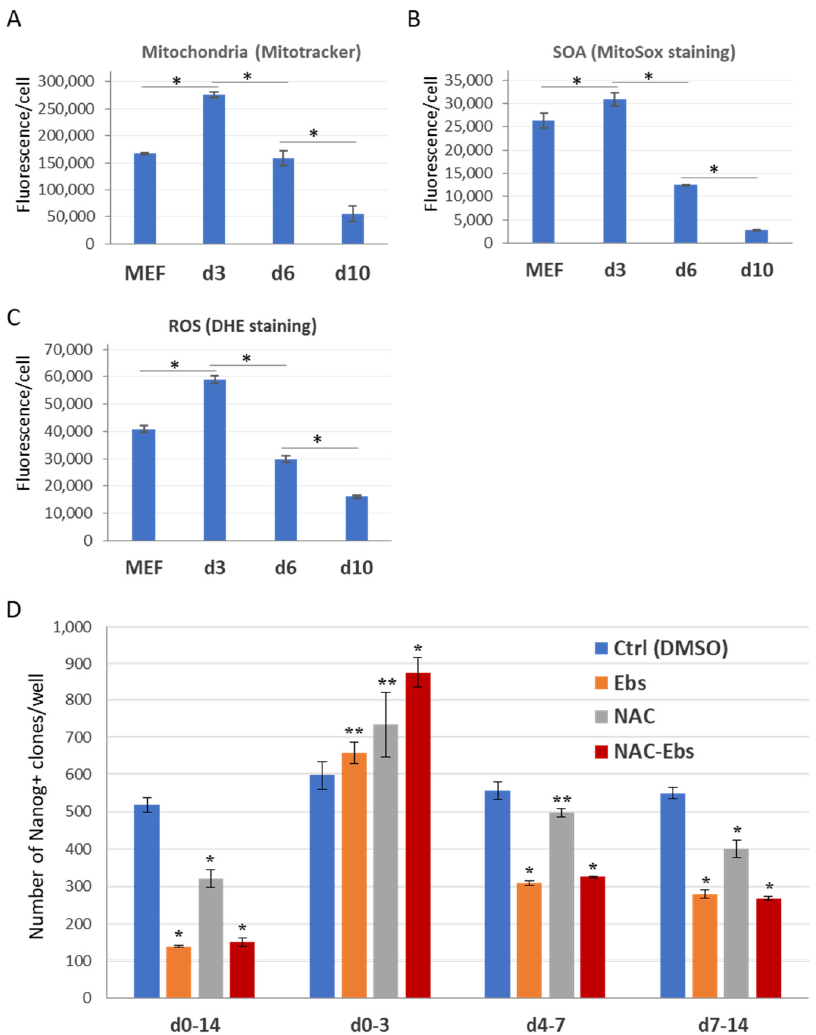
Figure 4. ROS exerts opposite effects during early (day 0–3) vs. later phases (day 4–14) of reprogramming. Transient increase of mitochondria numbers ( A ), SOA ( B ), and ROS ( C ) on day 3, followed by their dramatic decrease by day 10 of reprogramming. The parameters were measured by Mitotracker, MitoSox, and DHE staining, respectively. The charts show mean fluorescence per cell ± SD, n = 3, * p < 0.001. ( D ) The ROS scavenging with antioxidants between day 0 and 3 of reprogramming increases, whereas after day 4 it reduces the efficiency of iPSC generation. The chart shows mean of Nanog-positive iPSCs clone numbers per well ± SD, n = 3, * p < 0.001, ** p < 0.05.